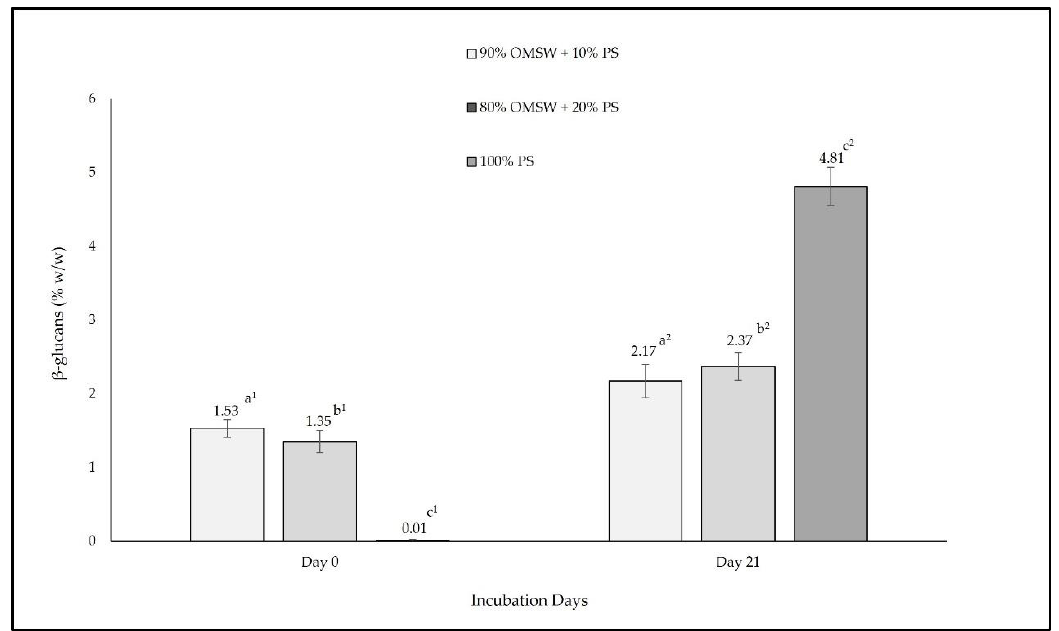
Figure 9. Assessment of Lignin content for PS and its mixtures with LPs. Statistical analysis was performed for each substrate individually between Day 0 and Day 21.